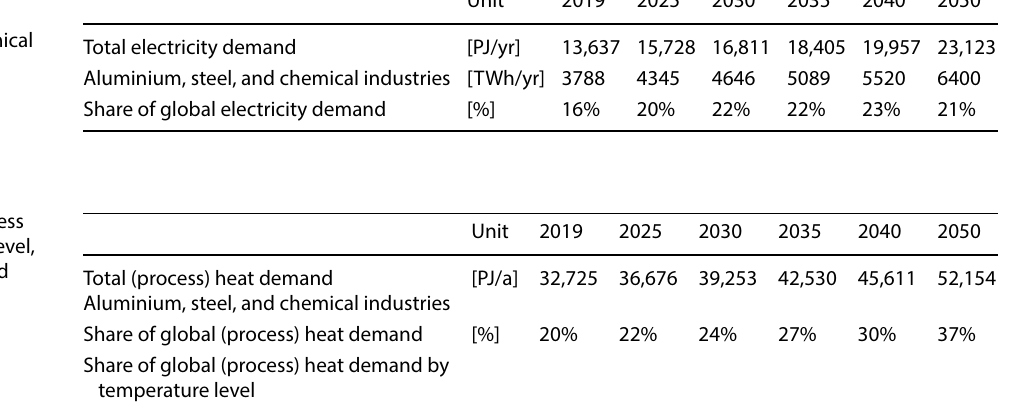
Table 15 Total global electricity demand for the aluminium, steel and chemical industries